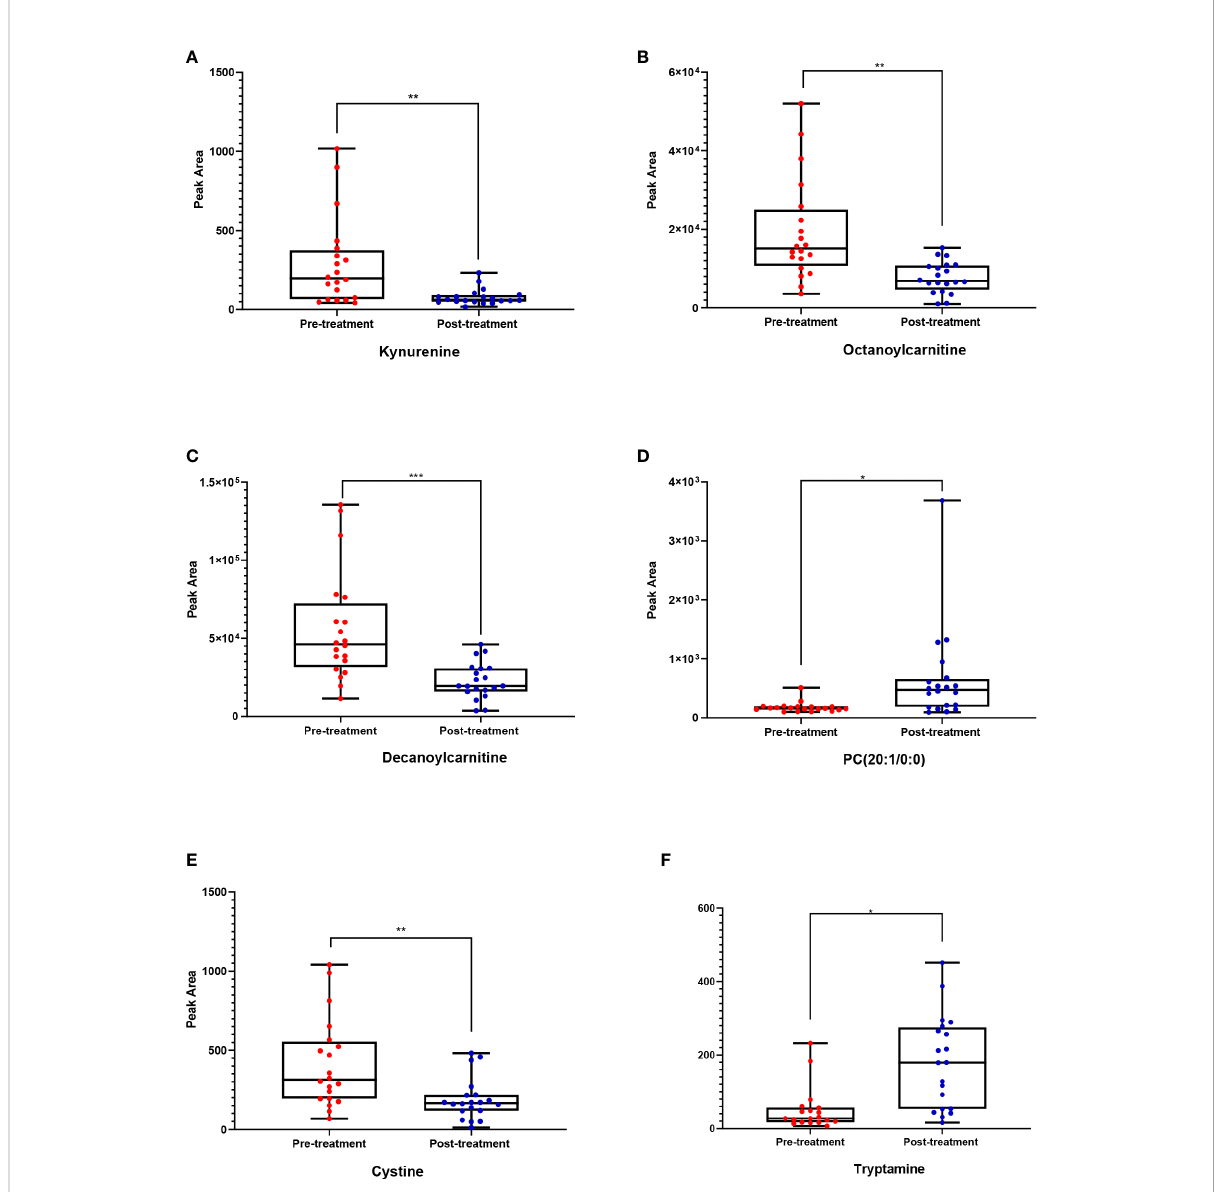
FIGURE 3 Box whisker plots for six putatively identi fi ed compounds for pre-treatment (red) (n=20 volunteers) and post-treatment (blue) cohorts (n=20). Where (A) Kynurenine, (B) Octanoylcarnitine, (C) Decanoylcarnitine, (D) PC (20:1/0:0), (E) Cystine, (F) Tryptamine. The signi fi cance represents the difference between pre- and post-treatment samples, where * = signi fi cant (p < 0.05), ** = very signi fi cant (p < 0.01), and *** = highly signi fi cant (P ≤